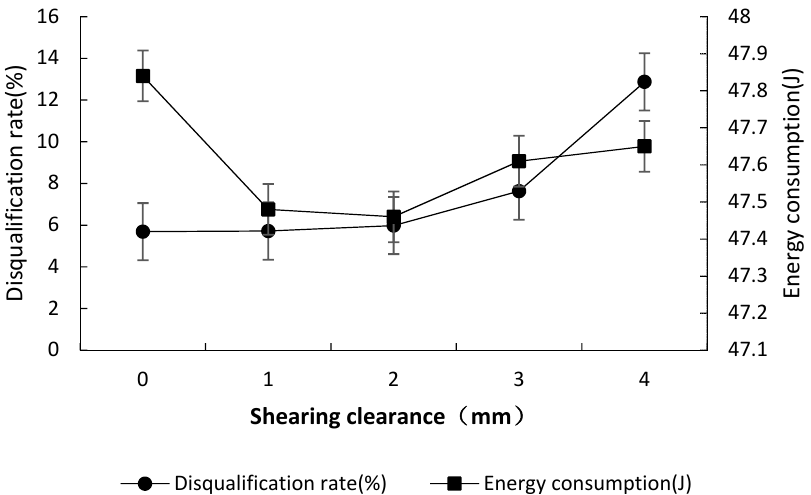
Figure 11. Experimental results of the influence of the cutting clearance on the qualification rate and energy consumption of straw crushing.